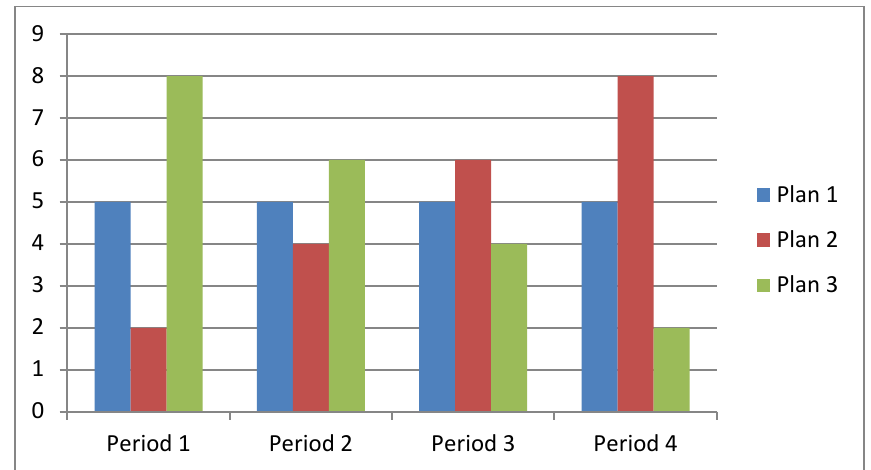
Figure 2 . Evolution of the repaid principal variable in arithmetic progression: constant (in blue), increasing (in red) or decreasing (in